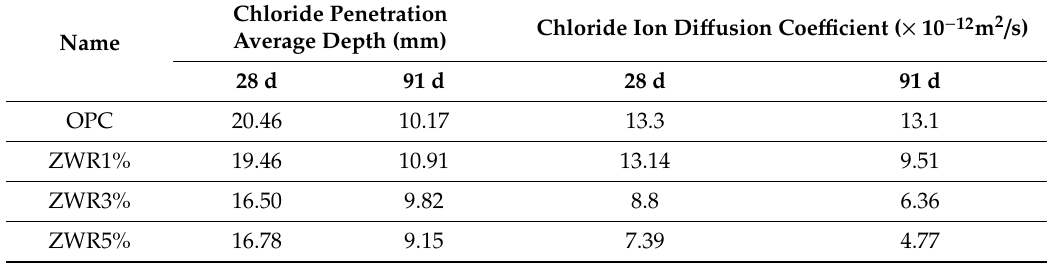
Table 11. Result of evaluation of resistance to chloride ion